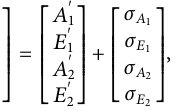
coordinates of theodolite 2